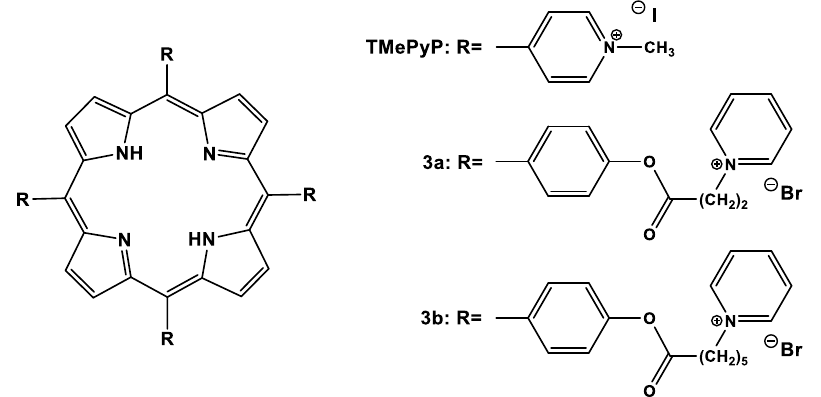
Figure 2. The structures of the investigated compounds.